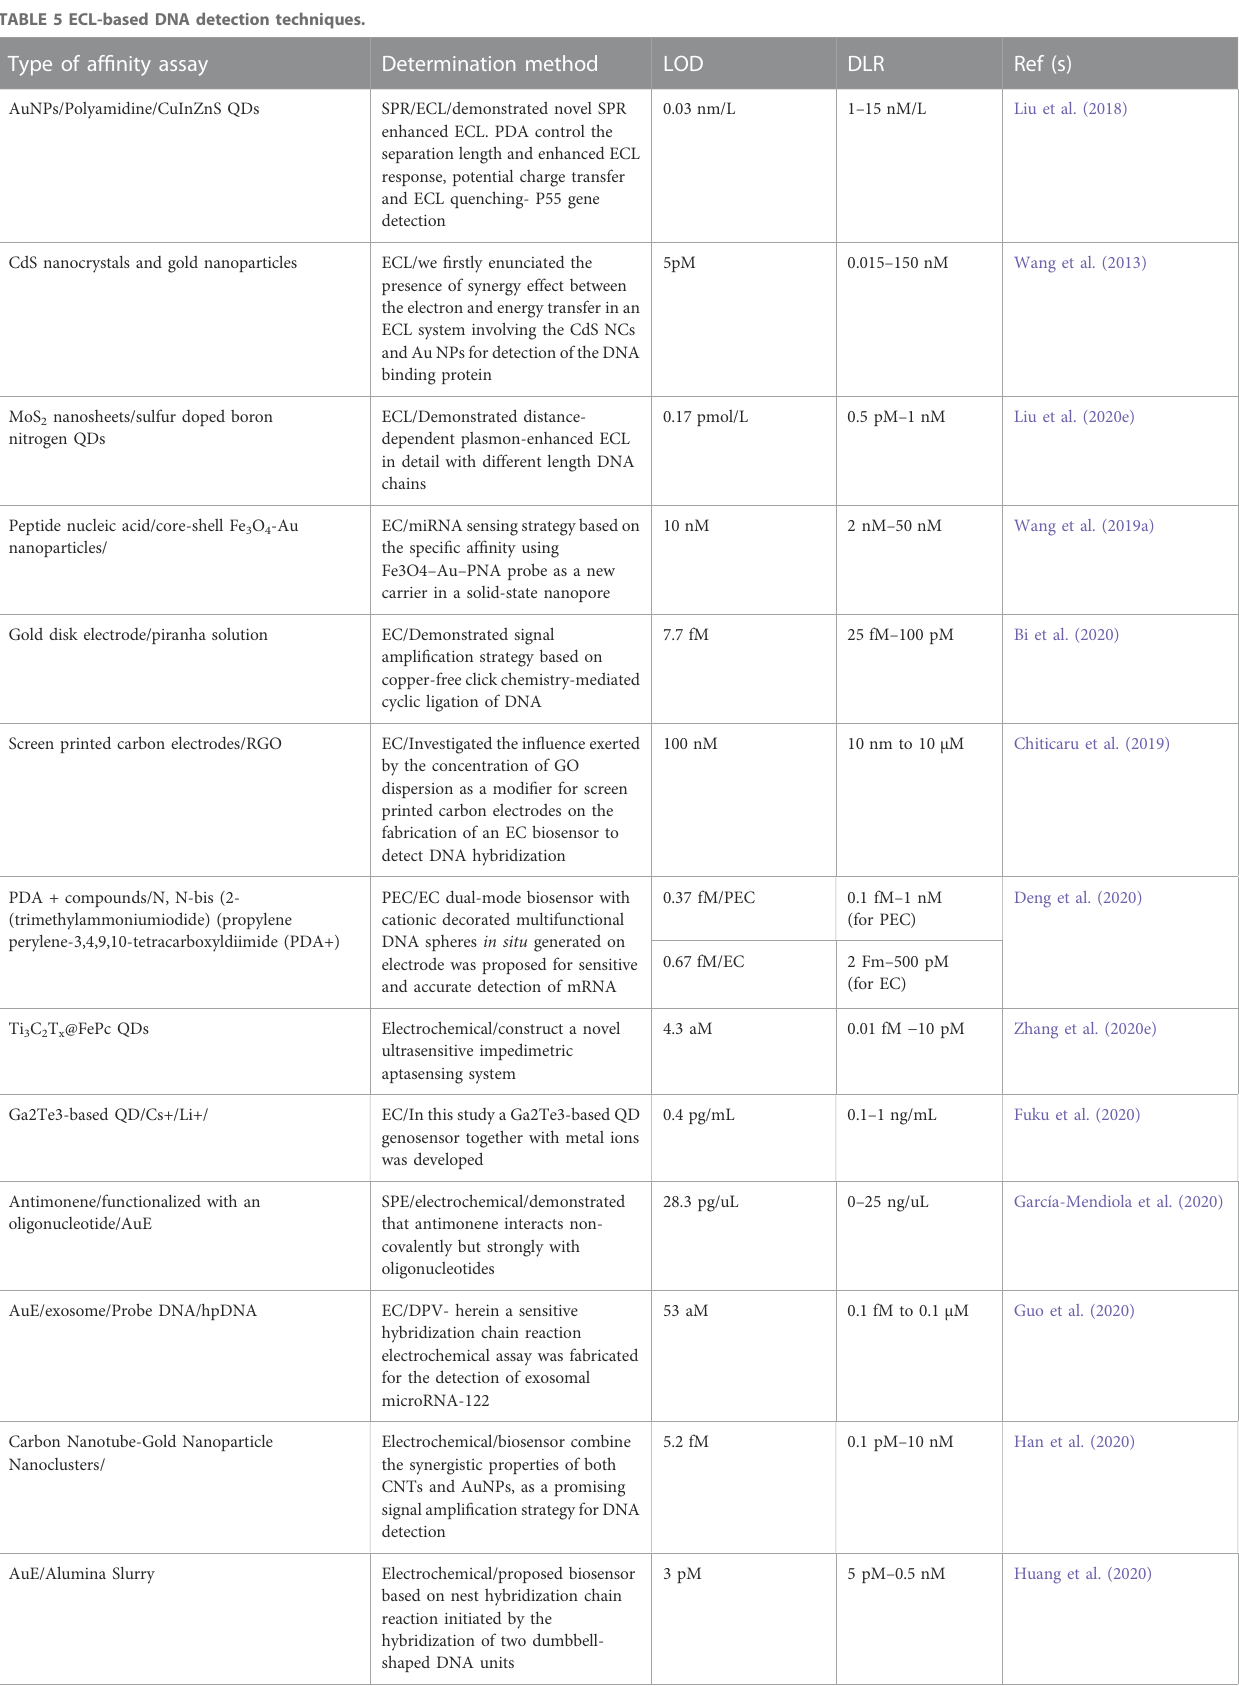
TABLE 5 ECL-based DNA detection